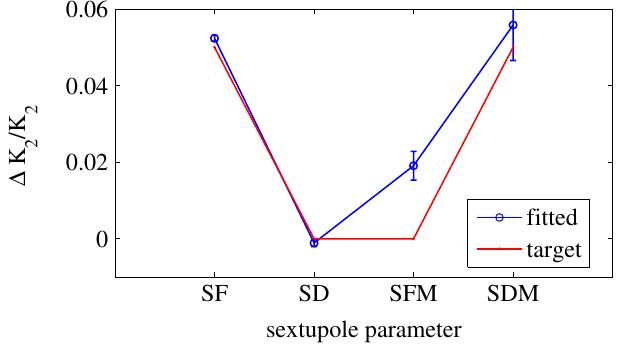
FIG. 7. The residual beta beat vs gain errors of BPM 0 and 1. ¼ 1 (cid:1) (cid:2) and g ¼ 1 þ (cid:2) for BPM 0 and The gain errors are g x y ¼ 1 þ (cid:2) and g ¼ 1 (cid:1) (cid:2) for BPM 1. The roll errors are fixed g x y at (cid:1) 10 mrad and 10 mrad for the two BPMs,